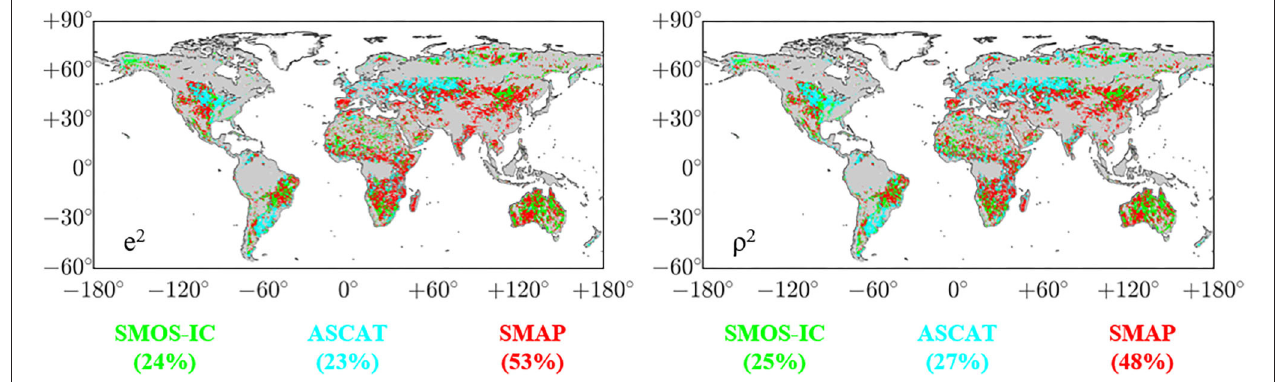
Figure A1 | Global rank maps showing soil moisture datasets, SMAP (red), SMOS-IC (green), and ASCAT (cyan) presenting the lowest error variances e 2 (Left) and the highest squared Pearson correlation coefficients ρ 2 (Right) . Here, the results of ASCAT are represented as averages of the results from the three data triplets, and the numerical values in parentheses represent proportions in percentages that the three soil moisture datasets show the lowest (highest) e 2 ( ρ 2 ). Here the gray background on land indicates regions masked by the data preprocessing described in section Data.